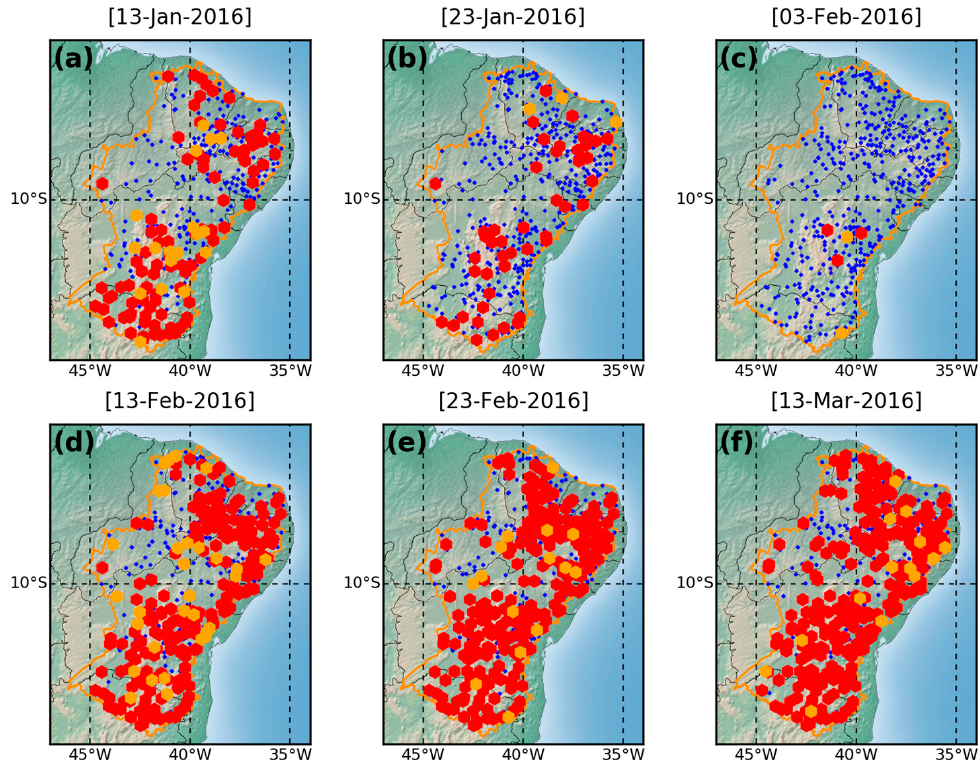
Figure 9. Index of Stress in Agriculture (ISA) for different dates. Red symbols denote seven consecutive days of SMI < 0.4, while orange symbols mark where SMI < 0.4 for three days. Current stations marked in blue.